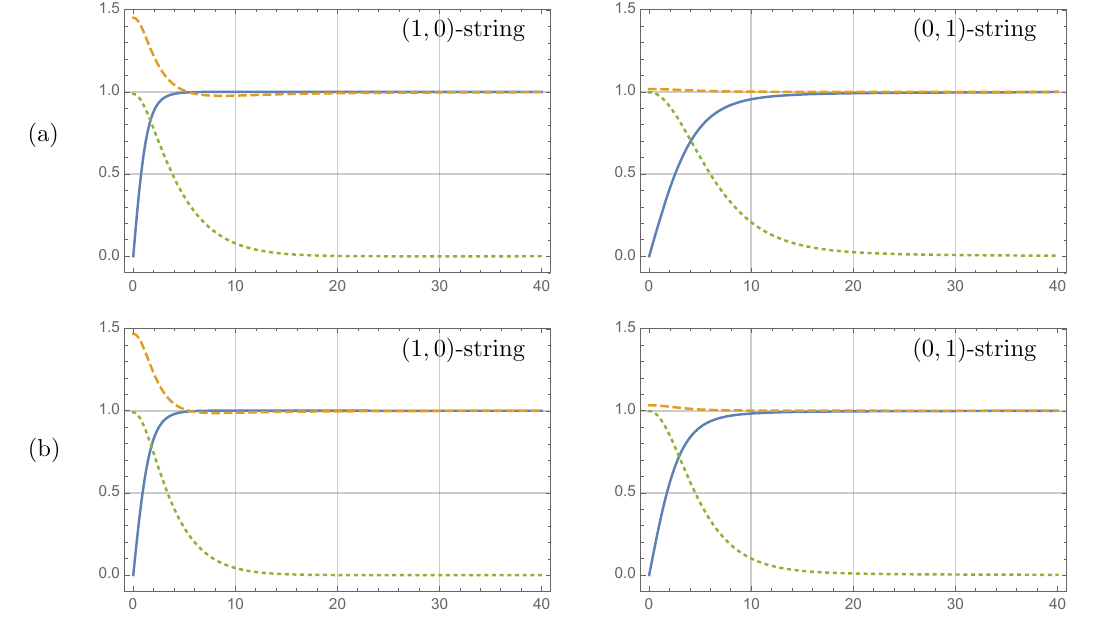
Figure 11 . The pro(cid:12)le functions f ( r ) (solid), h ( r ) (dashed), and w ( r ) (dotted) are shown for the (1 ; 0)- and (0 ; 1)-strings. We set tan (cid:12) = 3 by taking ( (cid:22); (cid:21) 3 ) = panels (a), and ( (cid:22); (cid:21) 3 ) = g = g 0 = (cid:21) 1 = (cid:21) 2 = (cid:21) 4 =